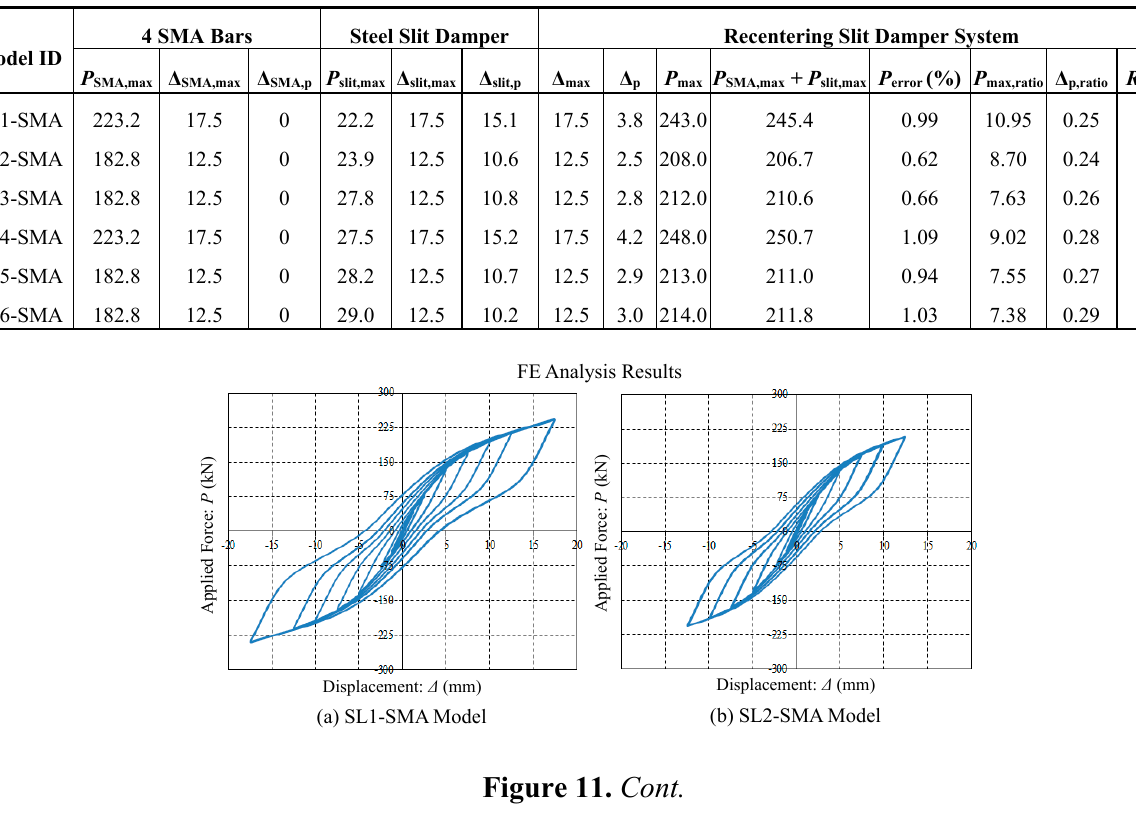
Table 3. Summary of FE analysis